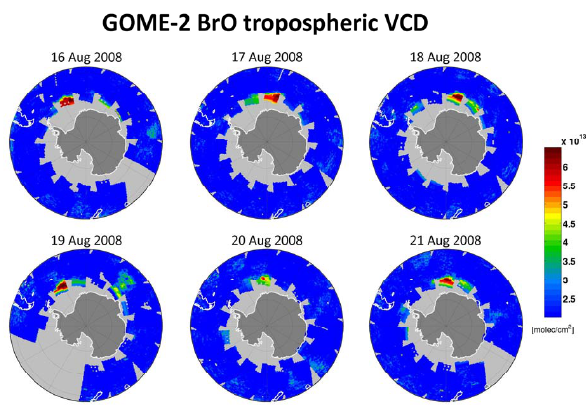
Fig. 4. Tropospheric vertical column density BrO derived from the Figure 4. Tropospheric vertical column density BrO derived from the GOME ‐ 2 instrument during the 584 GOME-2 instrument during the August ozone depletion event. Ar- August ozone depletion event. Areas of light grey have no data. 585 eas of light grey have no